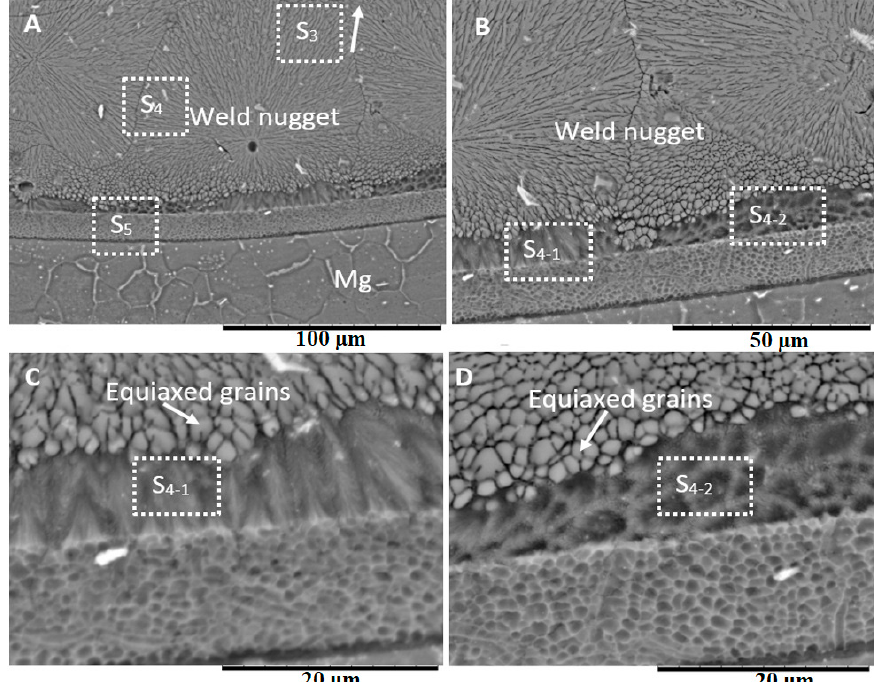
Figure 6. ( A ) Micrograph of the Mg fusion interface; ( B ) Magnified image of the Mg interface; ( C ) detail micrograph of phase S 4-1 ; ( D ) Detailed microstructure of S 4-2.